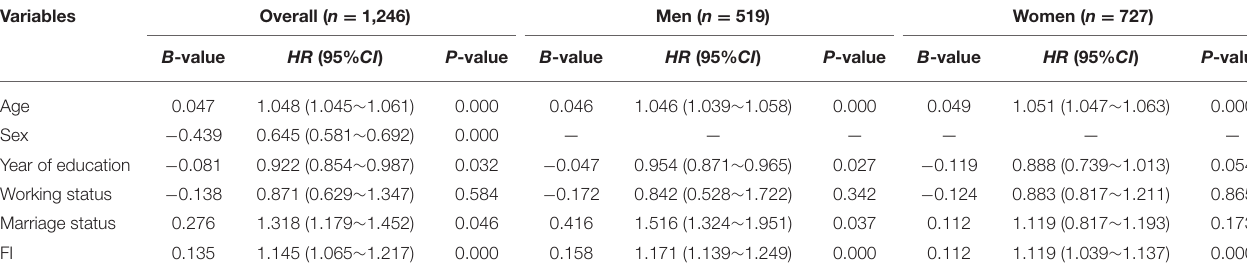
TABLE 2 | Multivariate Cox regression analysis of the impact of FI on 10-year mortality risk in the elderly population of different genders. Variables